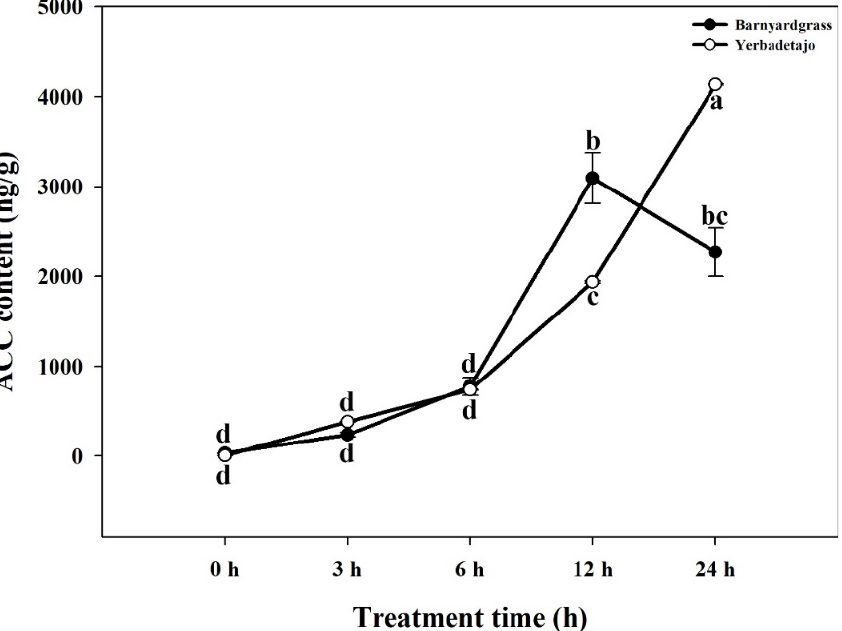
Figure 2. ACC content in barnyardgrass and yerbadetajo after florpyrauxifen-benzyl treatment. The X -axis represents the treatment time; the Y -axis represents ACC content. a–d represents the significance level ( p < 0.05) (the significance mark of barnyardgrass is above the broken line, and the significance mark of yerbadetajo is below the broken line). The standard errors of the means are described by vertical bars.